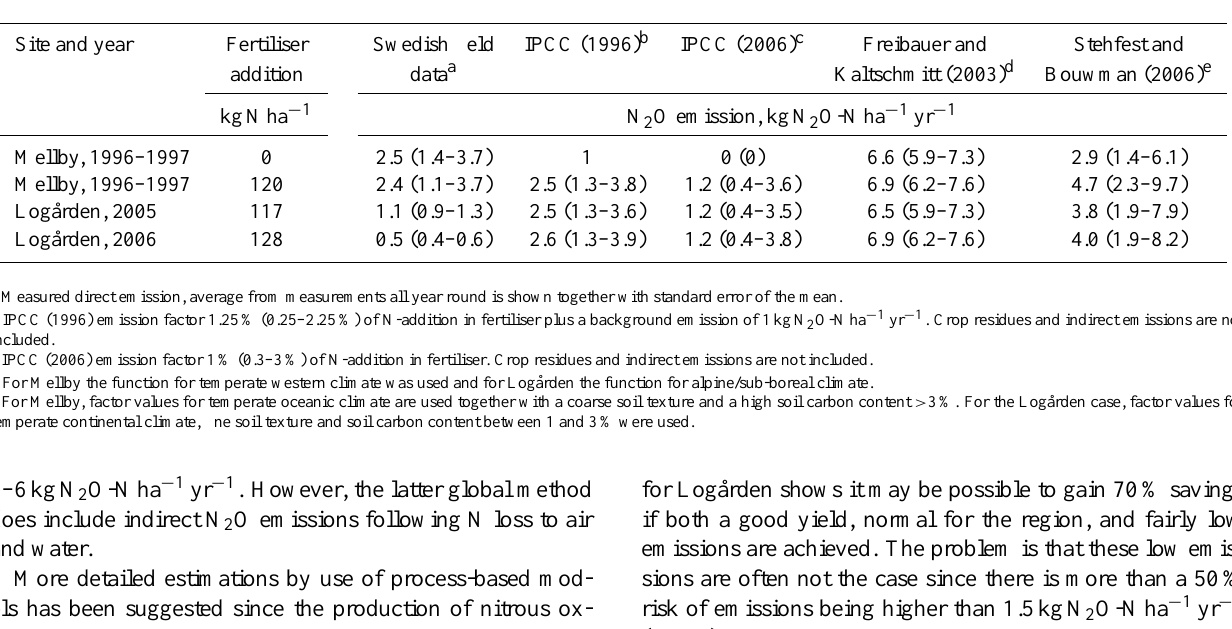
Table 2. Comparison between measured and calculated direct nitrous oxide emission. Measured data are from Mellby and Log˚arden in Sweden, having mineral soils cropped with spring wheat, with the addition of mineral fertilisers.